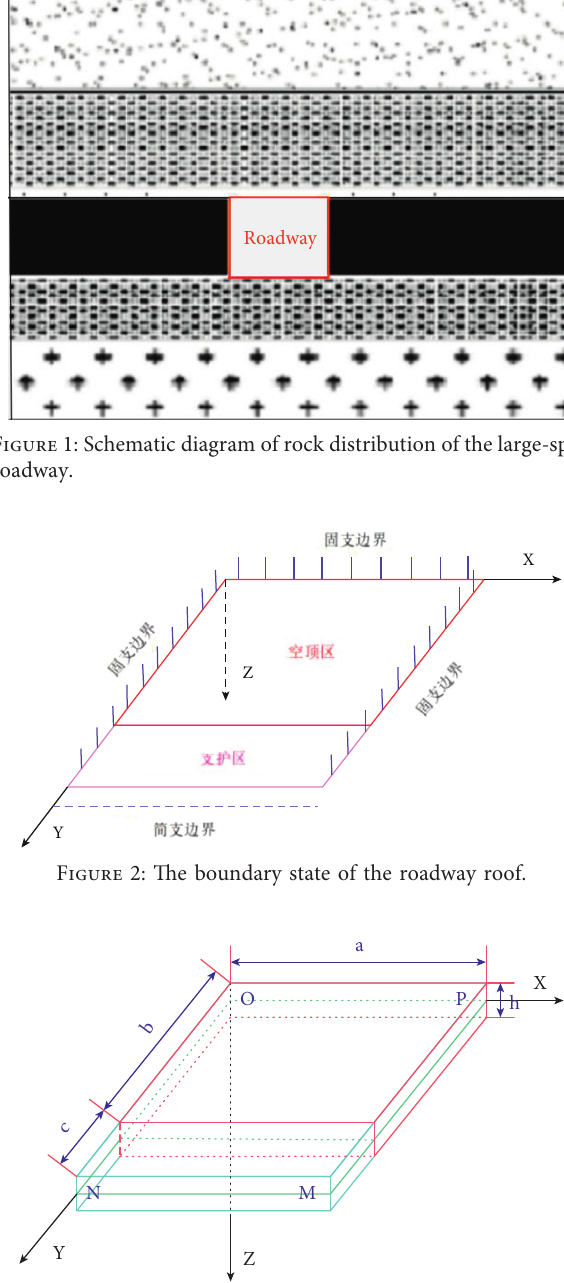
Figure 3: Mechanical model of the roadway roof.